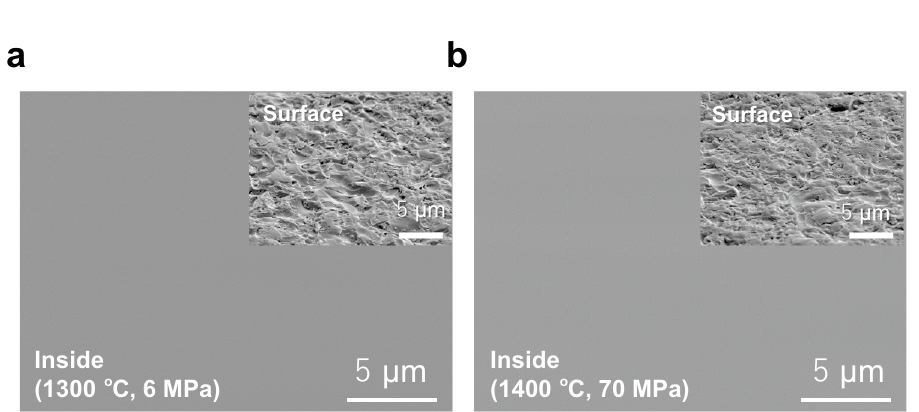
Figure 3. SEM observation of SPS-SiO 2 glasses. SEM images of interiors of the SPS-SiO 2 glasses prepared at 6 MPa, 1300 °C ( a ) and 70 MPa, 1400 °C ( b ), respectively. The insets show the surface of the samples. The surface and the interior of the samples were polished mechanically and by ion-milling,